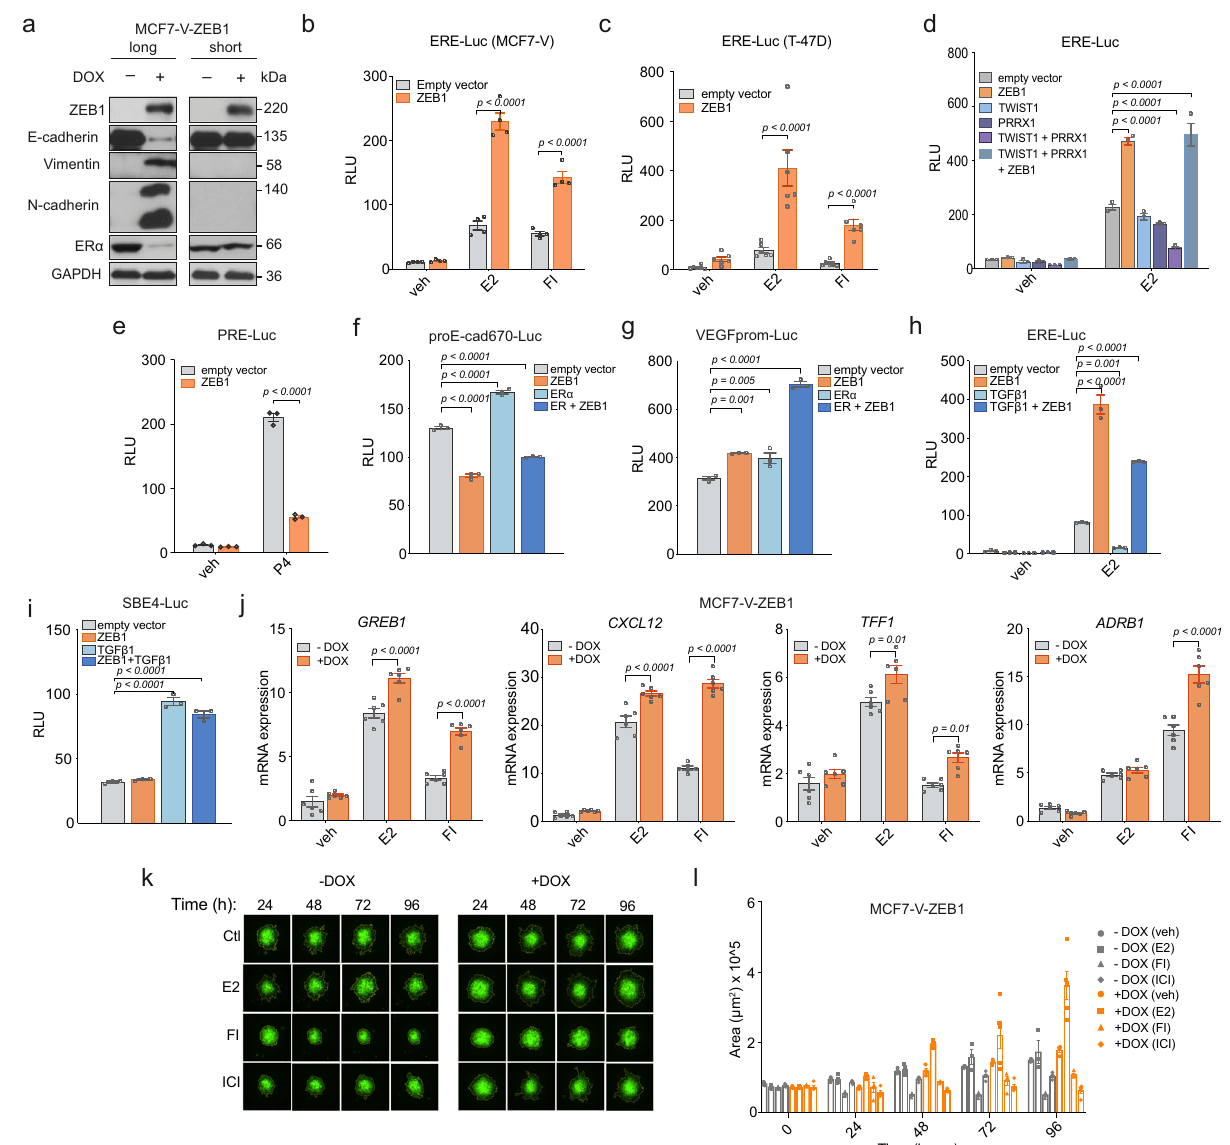
Fig. 1 Expression of ZEB1 potentiates ER α activity and invasion of breast cancer cells. a MCF7-V-ZEB1 cells in the presence of doxycycline ( + DOX) express ZEB1. Immunoblots show the levels of EMT markers and ER α after long-term (8 – 12 weeks) and short-term (1 – 2 weeks) expression of ZEB1 (results are representative of n = 3 independent experiments). b – i Luciferase reporter assays with transiently transfected cells as indicated, including for ZEB1, which was expressed from plasmid pTRIPz-puro-HA-ZEB1 with DOX treatment. Except for the experiments of b , c , all assays were done with HEK293T cells. The activities of ER α and PR, and the E-cadherin, VEGF, and TGF β -responsive promoter activities were monitored with the reporter plasmids ERE-Luc, PRE-Luc, and proE-cad670-Luc, VEGFprom-Luc, and SBE4-Luc, respectively. The luciferase activities (RLU) are expressed relative to the activities of the internal transfection standard, Renilla luciferase. Graphs are based on n = 4 for ( b ), n = 6 for ( c ), and n = 3 for ( d – i ) biologically independent experiments. j Expression of ER α target genes in MCF7-V-ZEB1 cells; mRNA levels were analyzed by RT-qPCR following 6 h of treatments as indicated; n = 3 biologically independent experiments, each including n = 2 technical replicates. k Representative images of a three-dimensional (3D) tumor invasion assay with MCF7-V-ZEB1 cells. l Invasion kinetics based on the area of n = 2 independent spheroids examined over three independent experiments as shown in k . veh, E2, FI, and ICI stand for vehicle, 17 β -estradiol, forskolin + IBMX, and fulvestrant, respectively. All error bars represent standard errors of the means (mean ± SEM). In b – j , p values are indicated above the bars; statistical signi fi cance was determined with one-way ANOVA for f , g , i and a two-way ANOVA for all other panels. Source data are provided as a Source Data fi